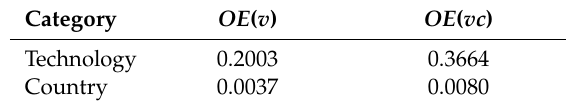
Table 12. The p -value of the rank sum test on output-based e ffi